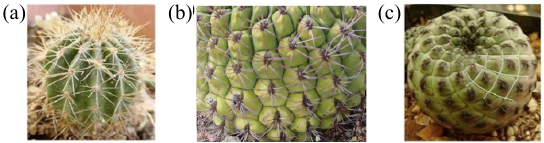
Fig. 2: Cacti displaying planforms of (a) ripples, (b) hexagons, and (c) squares.